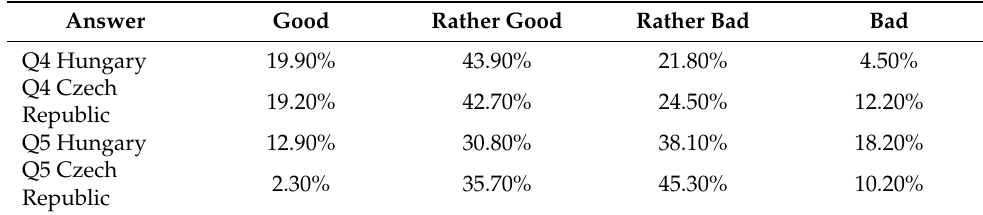
Table 1. Compared results for Q4 andQ5 [5].